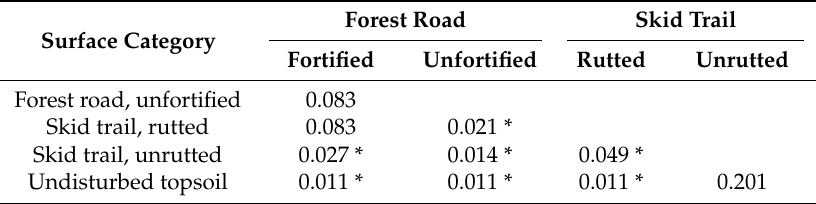
Table 11. Significance of surface type differences regarding soil erosion sums, Mann–Whitney test.